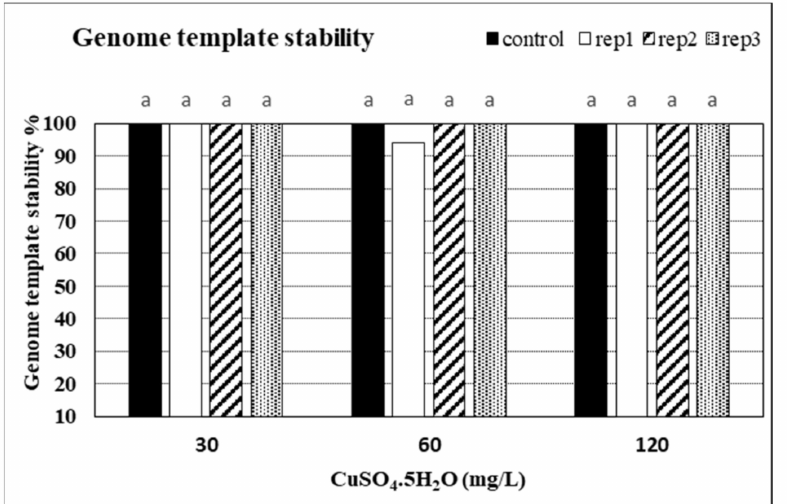
Figure 6. Genome template stability (GTS %) in in vitro banana plants treated with different concen- trations of CuSO 4 5H 2 O. Control = 0.025 mg L − 1 and represents the concentration of CuSO 4 5H 2 O in MS medium (without copper sulphate